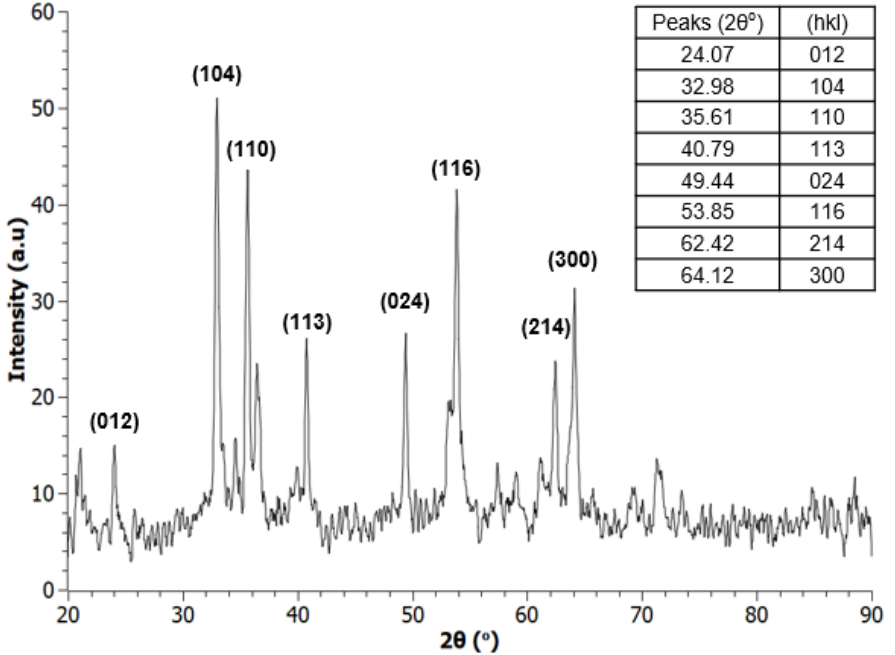
Figure 3. XRD spectra of α -Fe 2 O 3 (hematite), autoclaved at 160 ◦ C for 6 h.